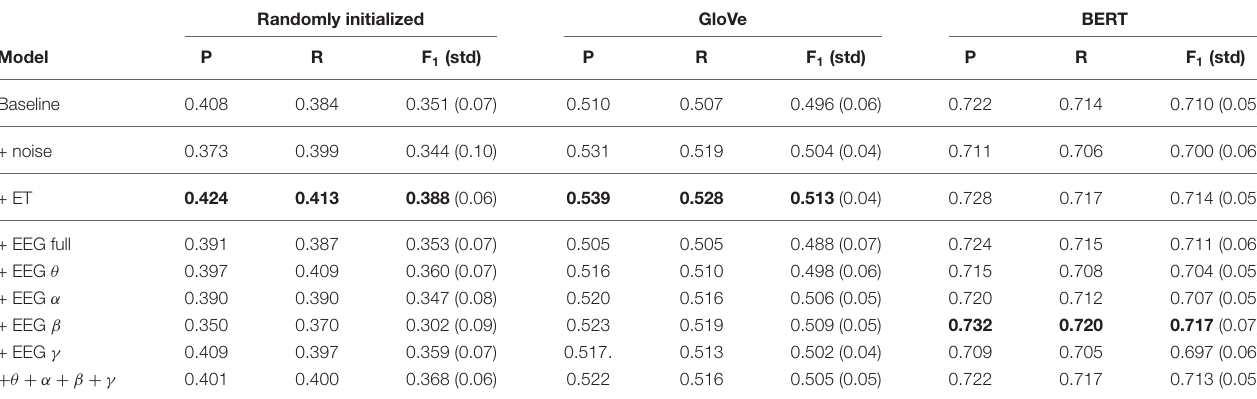
TABLE 5 | Ternary sentiment analysis results of the multi-modal model using the recurrent EEG decoding component . Randomly initialized GloVe